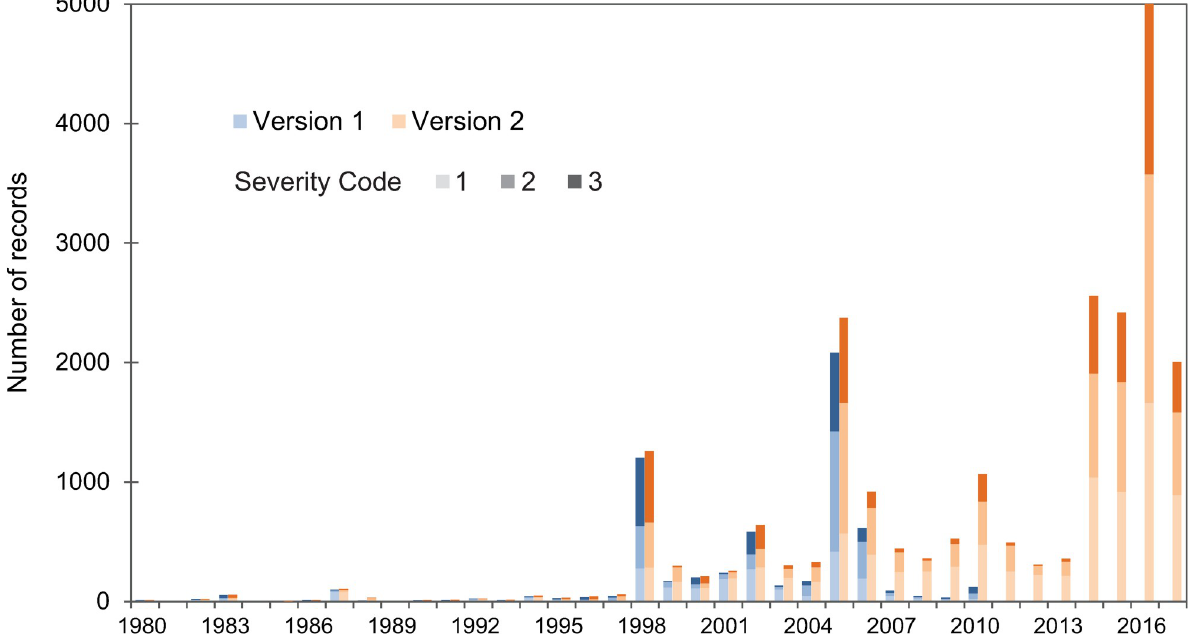
Fig 1. Number of bleaching reports by year for 1985–2017 in version 1 and version 2 of the database. Note that severity code 1 in this figure refers to severity code -1 or 1. Years: 1963, 1969, 1973, 1976–1977, and 1979–1984 do not appear in this figure but had bleaching reports.